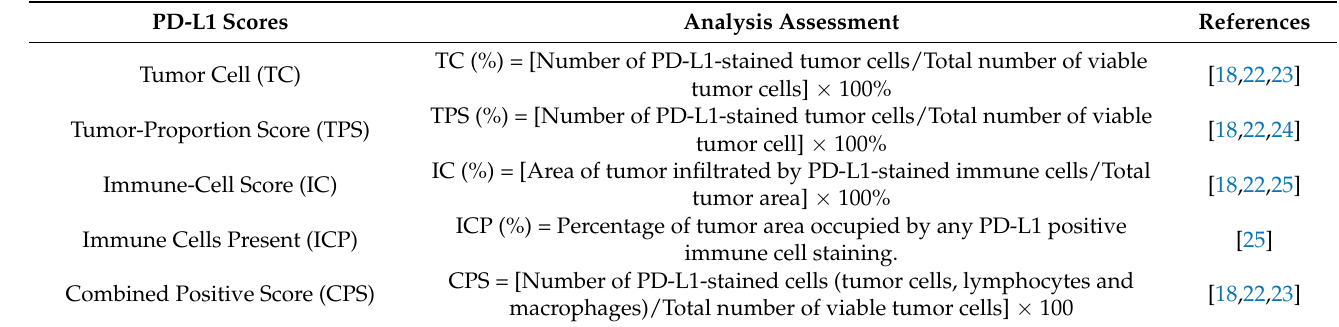
Table 1. Relevant PD-L1 scores assessment in malignant